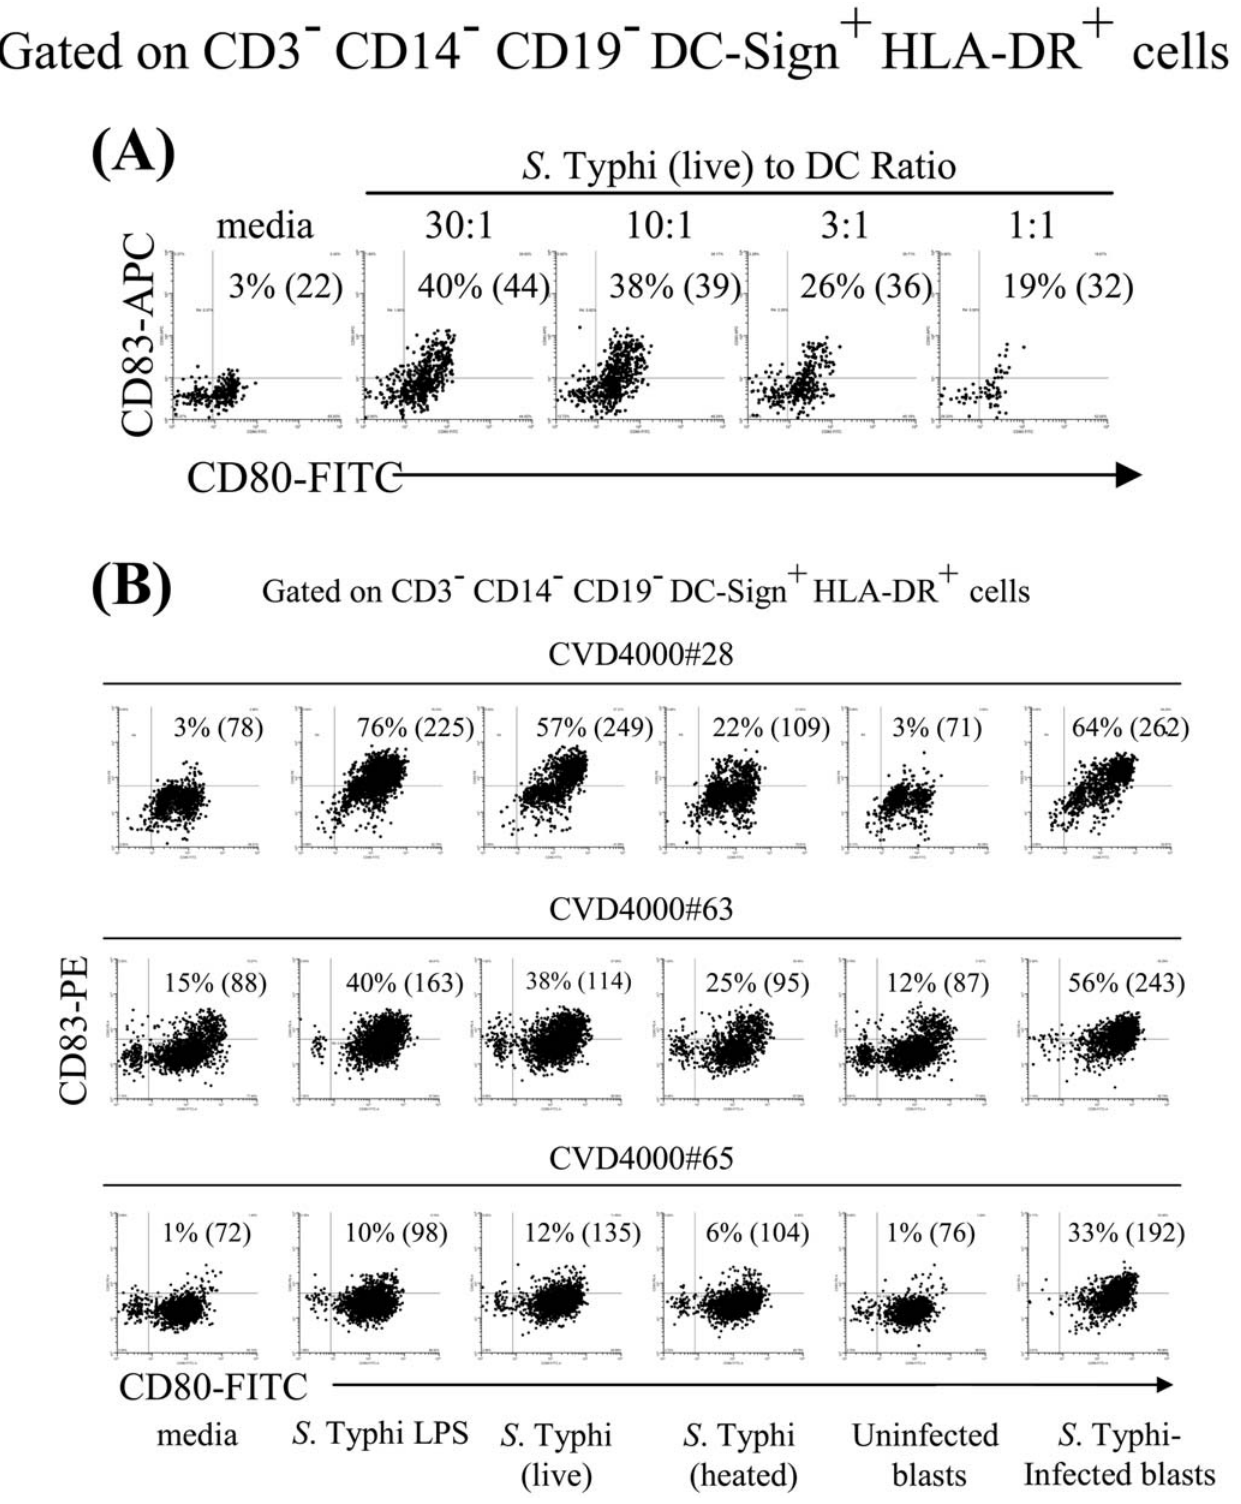
Figure 1. Modulation of cell surface expression of CD80 and CD83 molecules during S. Typhi-induced DC maturation. Immature DC were cultured for 30 h in the absence (media) or in the presence of LPS (1 m g/ml), with live or heat-killed S. Typhi at different MOI or uninfected or S. Typhi-infected blasts at a DC:blast ratio of 4:1. Cells were stained with mAbs to CD3, CD14, CD19, DC-Sign, HLA-DR, CD80 and CD83 or isotype- matched control Abs and analyzed by flow cytometry. Histogram shows the levels of CD80 and CD83 expression on CD3 2 CD14 2 CD19 2 DC-Sign + HLA-DR + gated cells. Numbers correspond to the % of CD80 + CD83 + positive cells in the indicated quadrant in each histogram followed by mean fluorescence intensity (MFI) of all CD80 positive cells (in parenthesis). Panel ‘‘ A ’’ shows the results of one volunteer, CVD5000 # 12U. Panel ‘‘ B ’’ shows the results of three volunteers, CVD4000 # 28, 63 and 65.